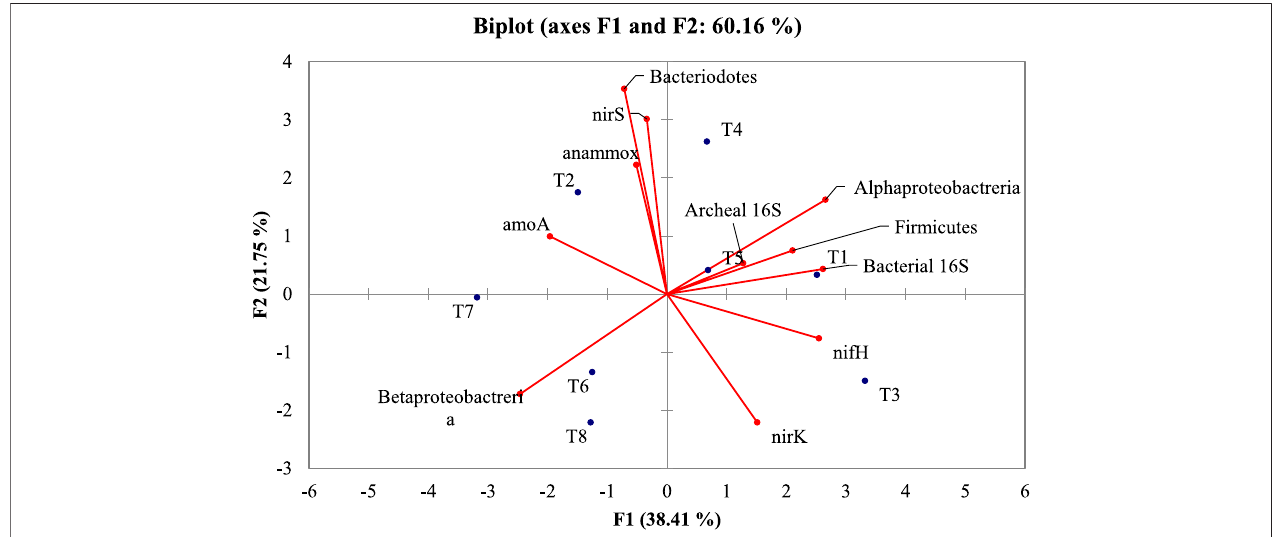
FIGURE 6 | PCA biplot depicting the taxonomic and functional gene markers of diverse microbial groups and treatments in crude oil forti fi ed sandy loam soil [T1 – soil;T2 – soil+crudeoil(1%);T3 – soil+crudeoil(1%)+bacterialconsortia( Pseudomonas sp.A3+ Bacillusamyloliquefaciens A9);T4 – soil+crudeoil(2%)+bacterial consortia ( Pseudomonas sp. A3 + Bacillus amyloliquefaciens A9); T5 – soil + crude oil (5%) + bacterial consortia ( Pseudomonas sp. A3 + Bacillus amyloliquefaciens A9); T6 – soil + crude oil (1%) + fungus ( Aspergillus sydowii AK20); T7 – soil + crude oil (2%) + fungus ( Aspergillus sydowii AK20); T8 – soil + crude oil (5%) + fungus ( Aspergillus sydowii